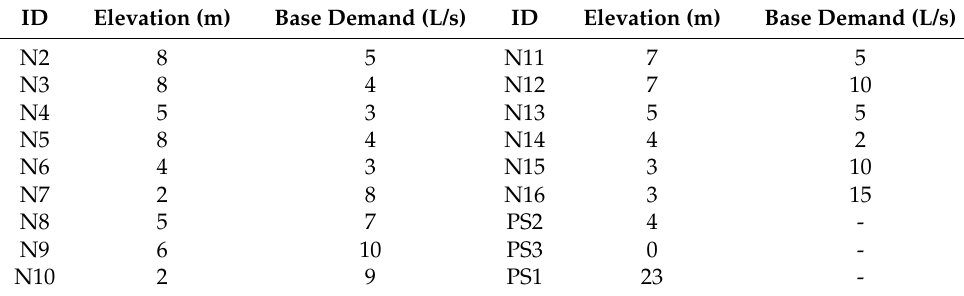
Table 1. Case study network: node information.